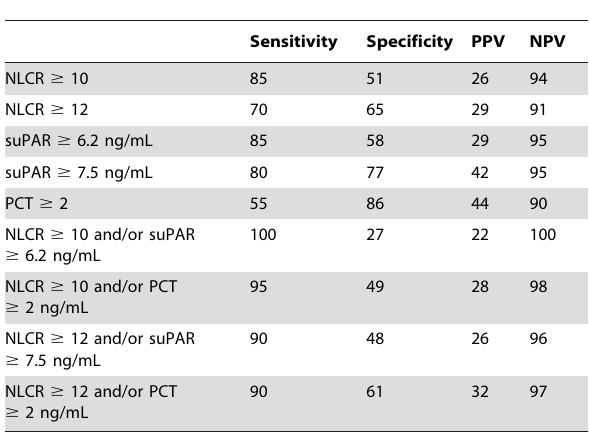
Table 3. Comparison of performance characteristics of the biomarkers and combinations in predicting bacteremia using different cut-off values.